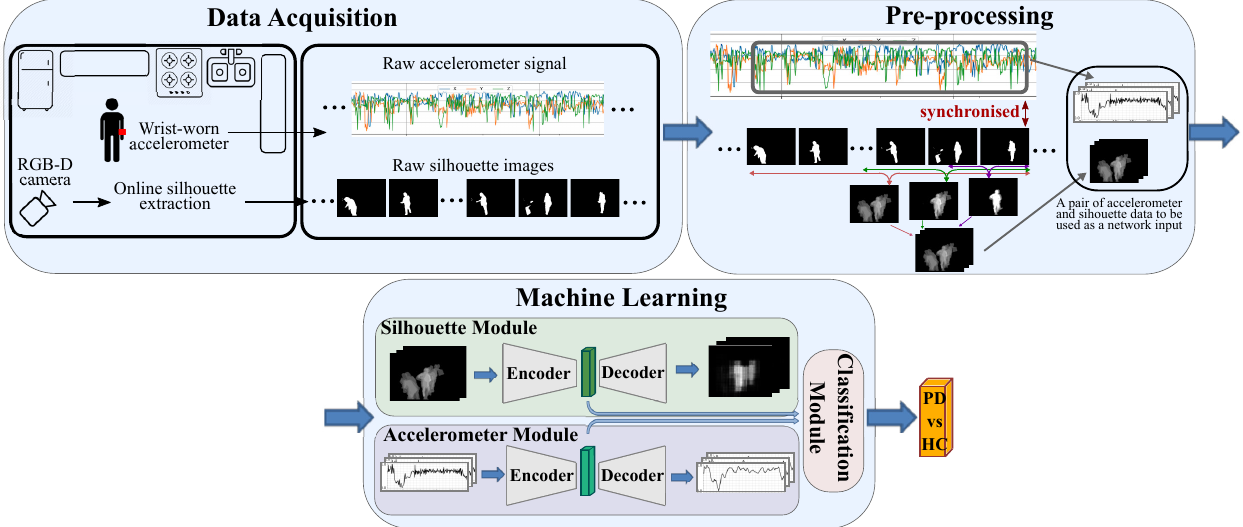
Figure 1. The overall scheme of our proposed approach for classifying PD vs. HC. First, data are recorded in a kitchen while the participant is cooking. They are then preprocessed to be given to the proposed machine learning algorithm for classification.